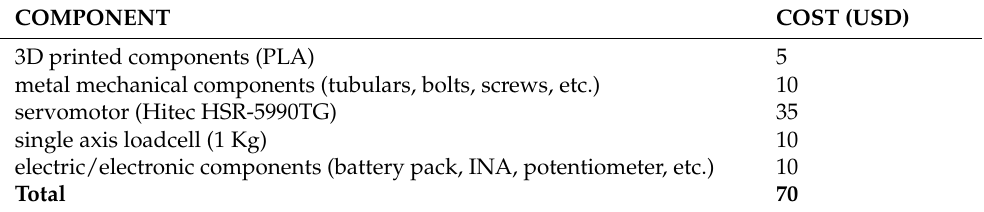
Table 1. List of components used for the realization of the electromechanical system, and related costs in USD.